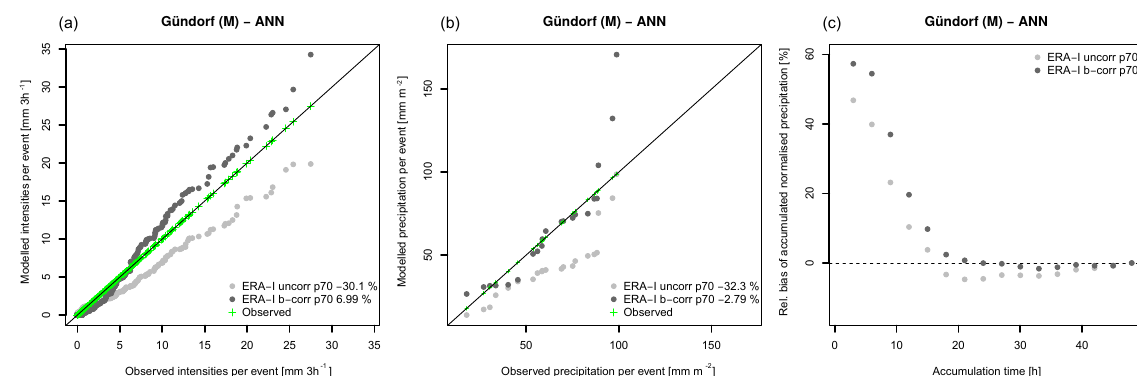
of the temporal distribution in WRF 3 km is a catchment- specific